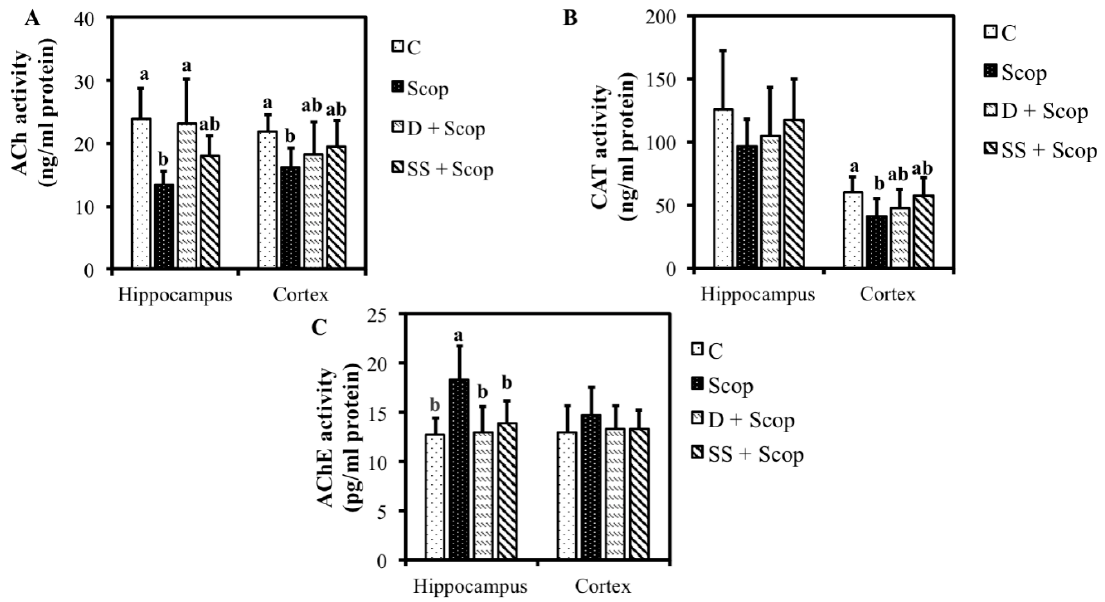
Figure 5. Effect of Stachys sieboldii in hippocampus and frontal cortex of animal brain Acetylcholine ( A ) Choline acetyl transferase, ( B ) and Acetylcholine esterase level ( C ). All values are mean ± SD ( n = 10). Mean with different superscripts in the same row such as a, b indicates significant difference by ANOVA with Tukey’s test at p < 0.05 compared to control group.